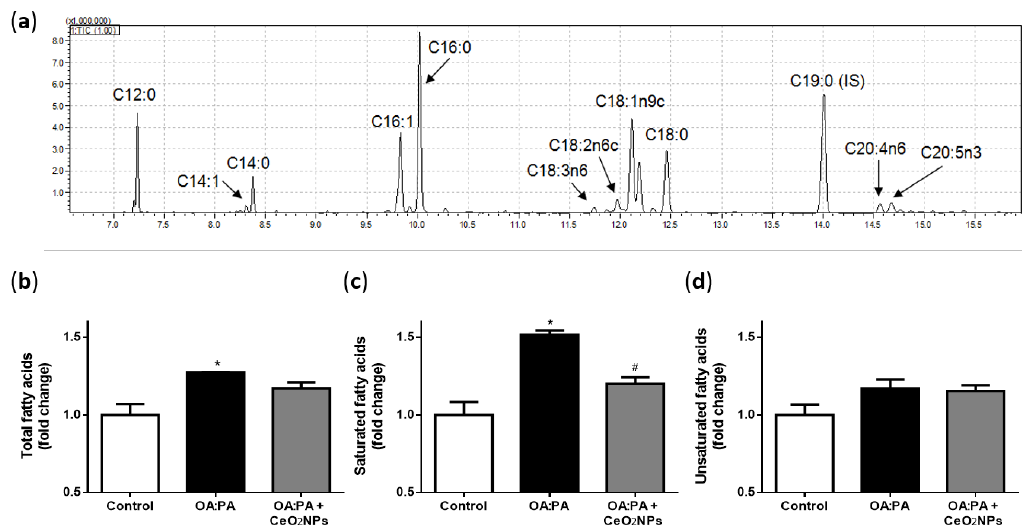
Figure 4. ( a ) Gas chromatography–mass spectrometry chromatogram of fatty acids in HepG2 cells. Content of total fatty acids ( b ), saturated fatty acids ( c ) and unsaturated fatty acids ( d ) in HepG2 cells exposed to vehicle (control), oleic acid:palmitic acid (OA:PA) (1.33:0.67 mM) and OA:PA with CeO 2 NPs (10 µg/mL). * p < 0.05 compared with control; # p < 0.05 compared with OA:PA.